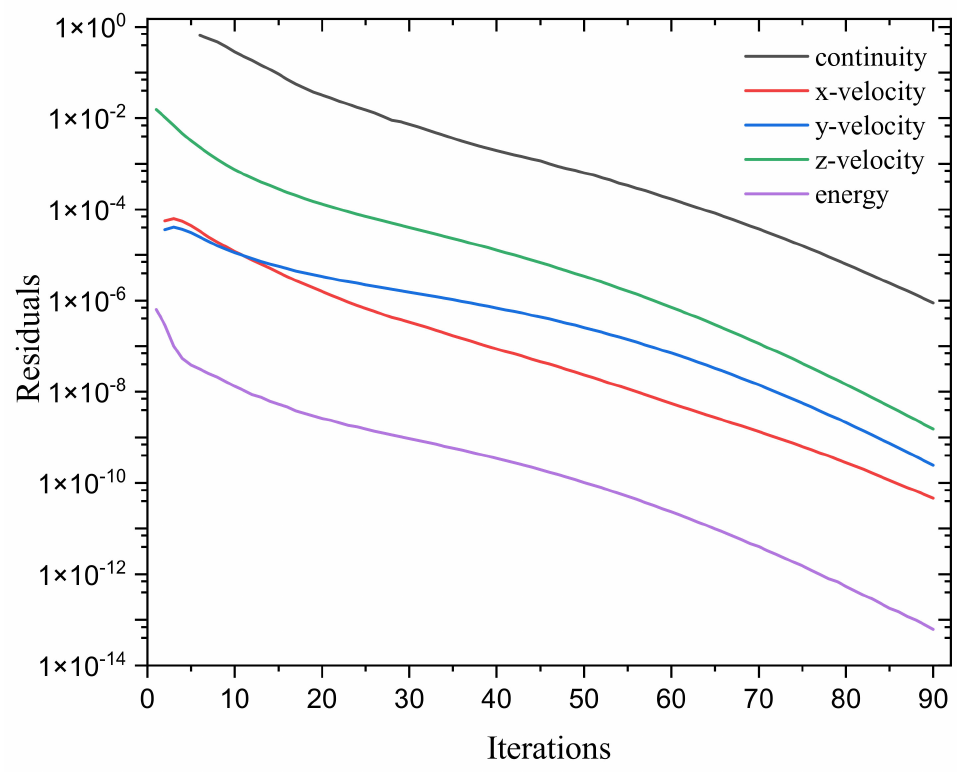
Figure 6. Residuals history obtained using the two-phase mixture model at Re = 455 with α nf = 4% and Φ =